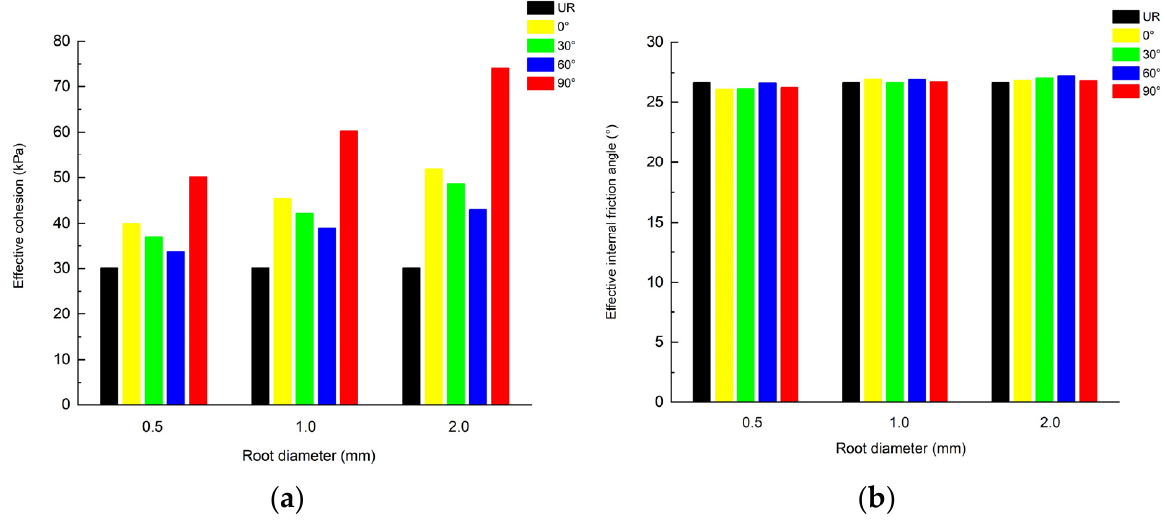
Figure 4. Variations of soil shear strength parameters under different conditions: ( a ) c (cid:48) and ( b ) ϕ (cid:48) .